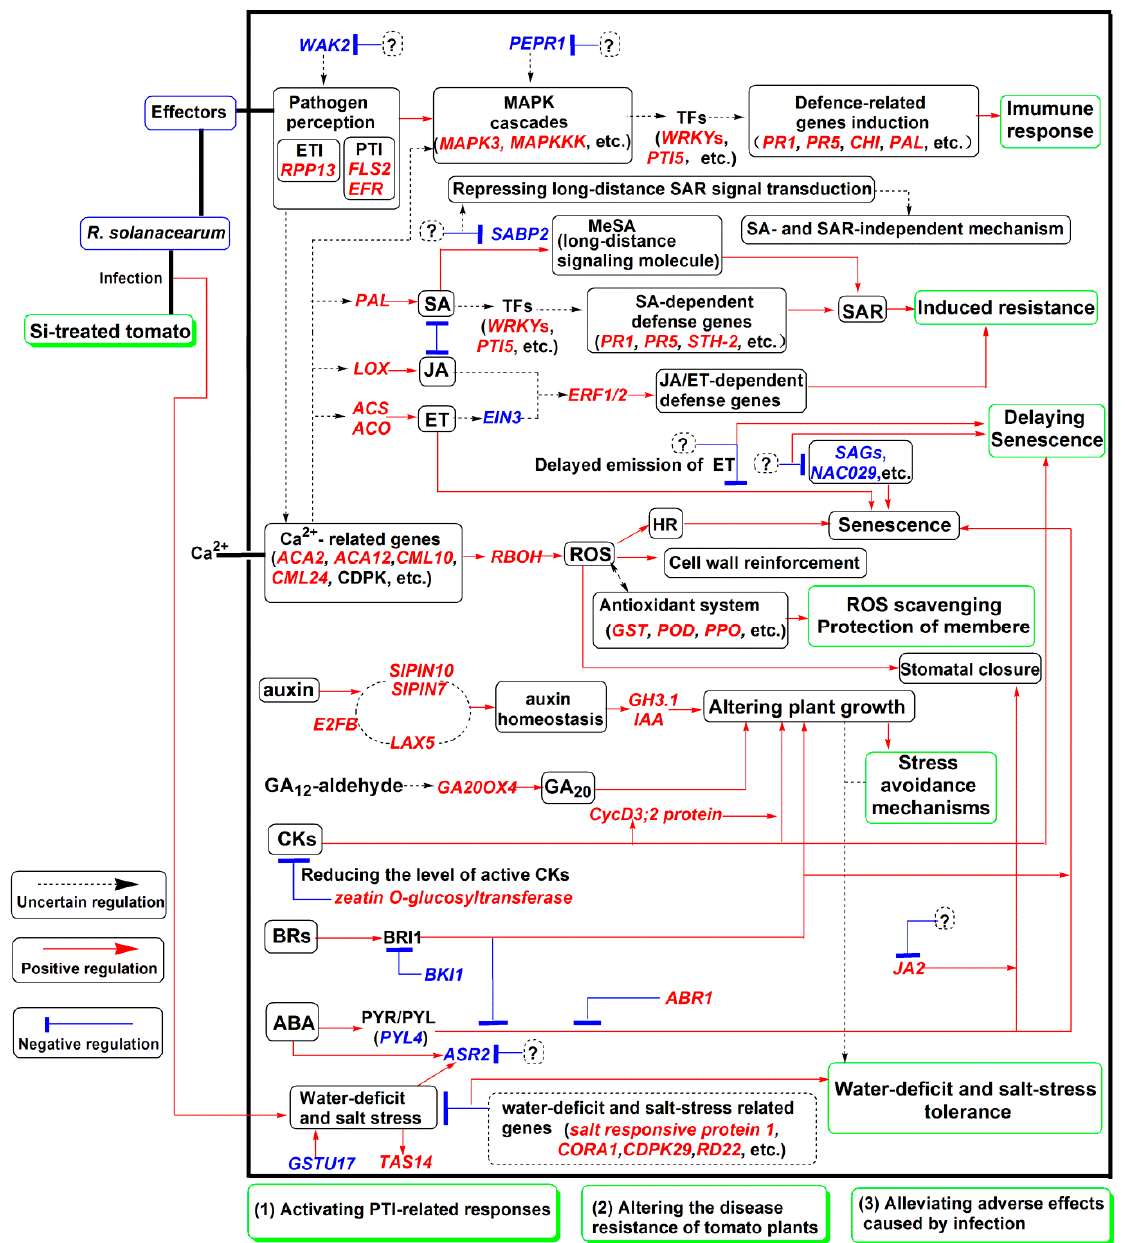
Figure 7. Hypothetical schematic model showing mechanisms involved in silicon (Si)-mediated tomato resistance against R. solanacearum . Upregulated genes are marked in red italics, and downregulated genes are marked in blue italics. Black dotted lines with arrows denote uncertain regulation; red lines with arrows denote positive regulation; and blue lines with bars indicate negative regulation. Question marks indicate unclear events. Several crosstalk and feedback mechanisms between multiple pathways are not presented in the model.